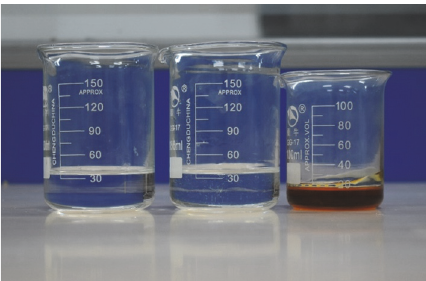
Figure 1: Raw materials for making transparent hard rock-like materials. From left to right: modified curing agent, epoxy resin #618, and